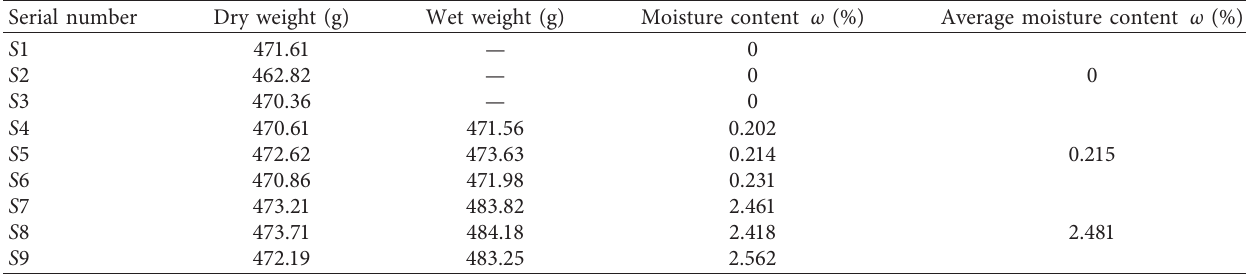
Table 1: Physical parameters of rock samples in different states.